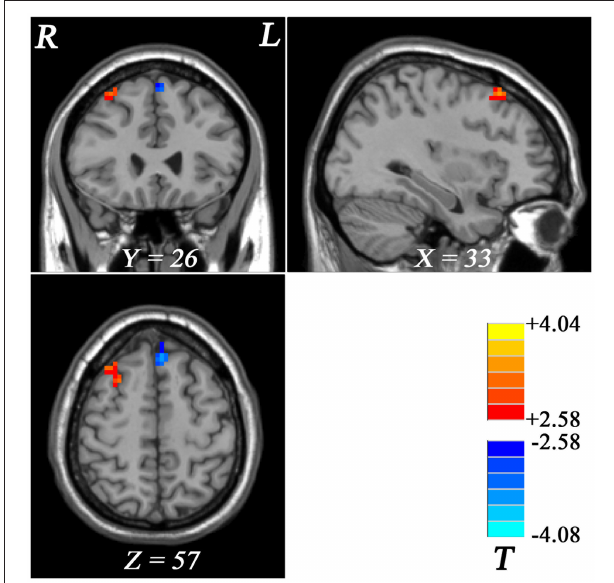
FIGURE 2 | Regional fALFF differences between GI-MDD patients and nGI-MDD patients. The color bar indicates the t values from post-hoc t -tests. Red and blue colors denote increased and decreased fALFF, respectively. fALFF , fractional amplitude of low-frequency fluctuation; GI-MDD , major depressive disorder with gastrointestinal symptoms; nGI-MDD , major depressive disorder without gastrointestinal symptoms.